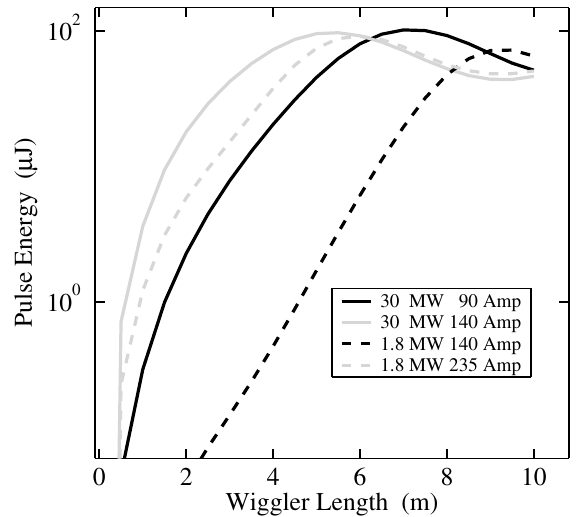
FIG. 9. (Color) Single shot energy measurement of SASE and HGHG for a time interval of 30 s for the same electron beam conditions. Top row is the SASE measurement and the bottom row is the HGHG measurement. The left column shows the actual measurements and the right one shows the histograms of SASE and HGHG output pulse energy with 30 MWseed power. to 3.5%.